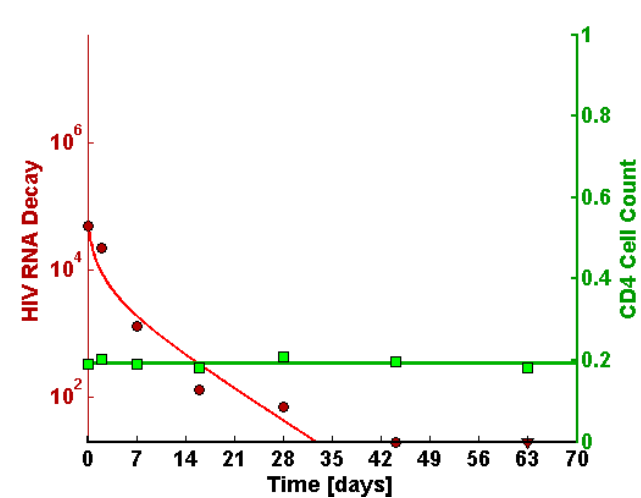
Fig. 5. Patient treated with Raltegravir and 2